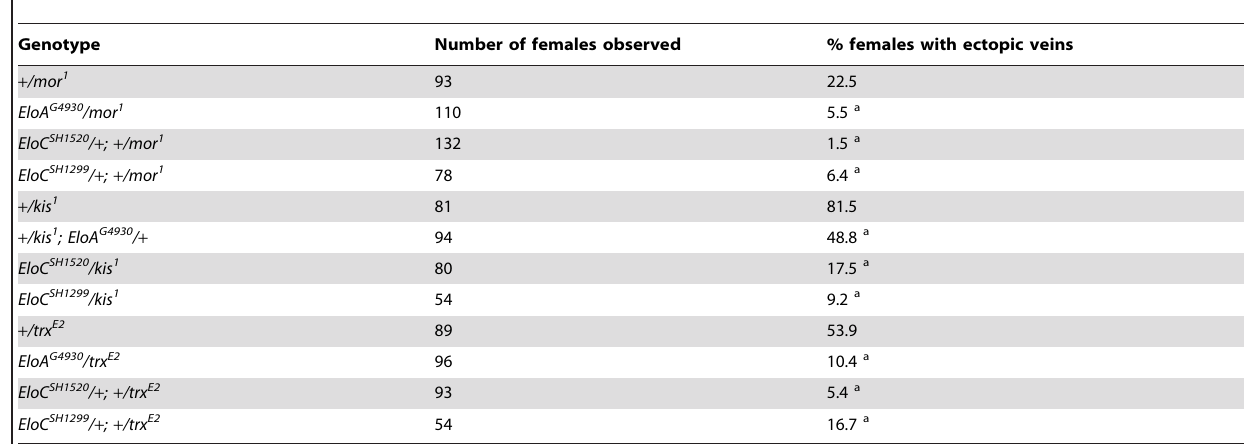
Table 4. Decreasing EloA or EloC expression partially suppresses ectopic veins induced by TrxG gene loss-of-function.